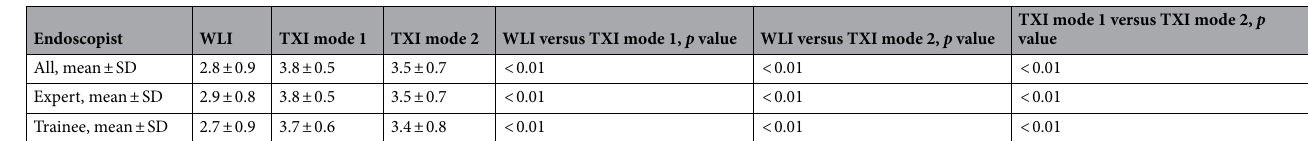
Table 1. Mean visibility scores for gastric mucosal atrophy determination using WLI, TXI mode 1, and TXI mode 2. WLI white-light imaging, TXI mode 1 Texture and Color Enhancement Imaging mode 1, TXI mode 2 Texture and Color Enhancement Imaging mode 2, SD standard deviation, NS not significant. p value: exact Wilcoxon signed-rank